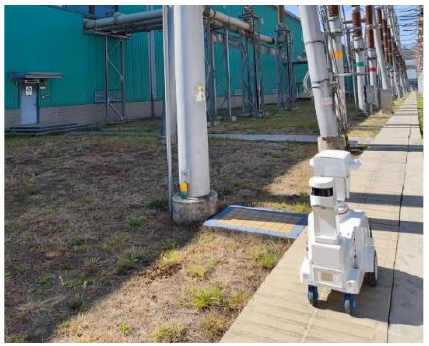
Figure 7. Inspection robot for